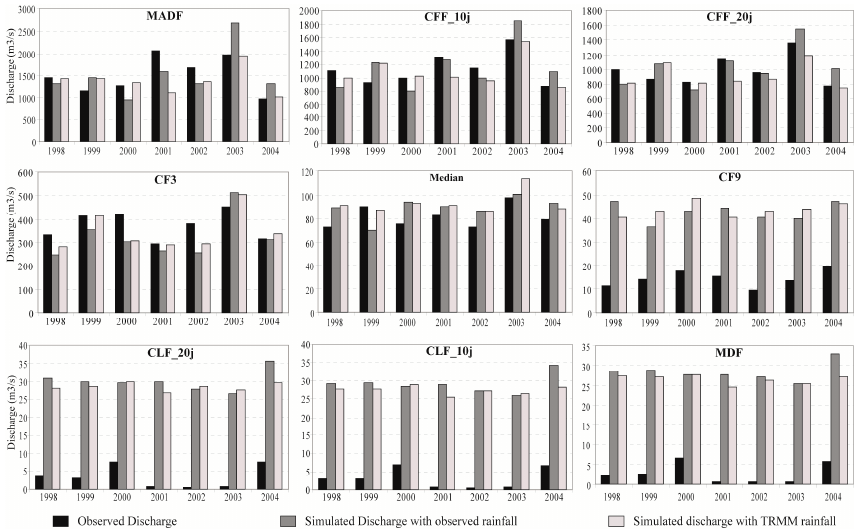
Figure 7. Comparison of simulated characteristic flow rates with ground and TRMM-based rainfalls against observed data.